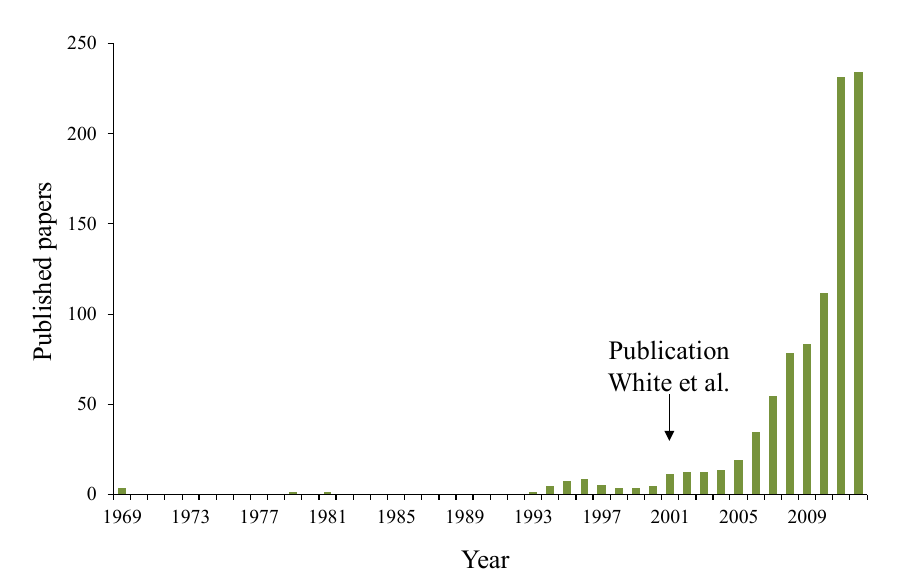
Figure 1. Evolution of the amount of papers published on self-healing materials (redrafted after slide shown by S. White during the International Conference on Self Healing Materials 2011 in